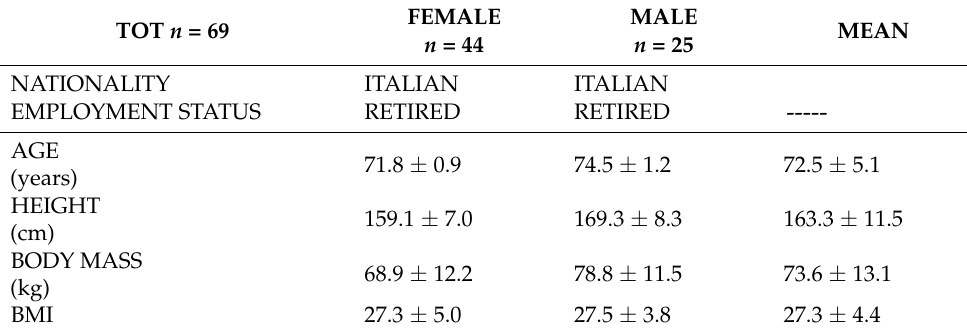
Table 1. Description of subjects’ characteristics.